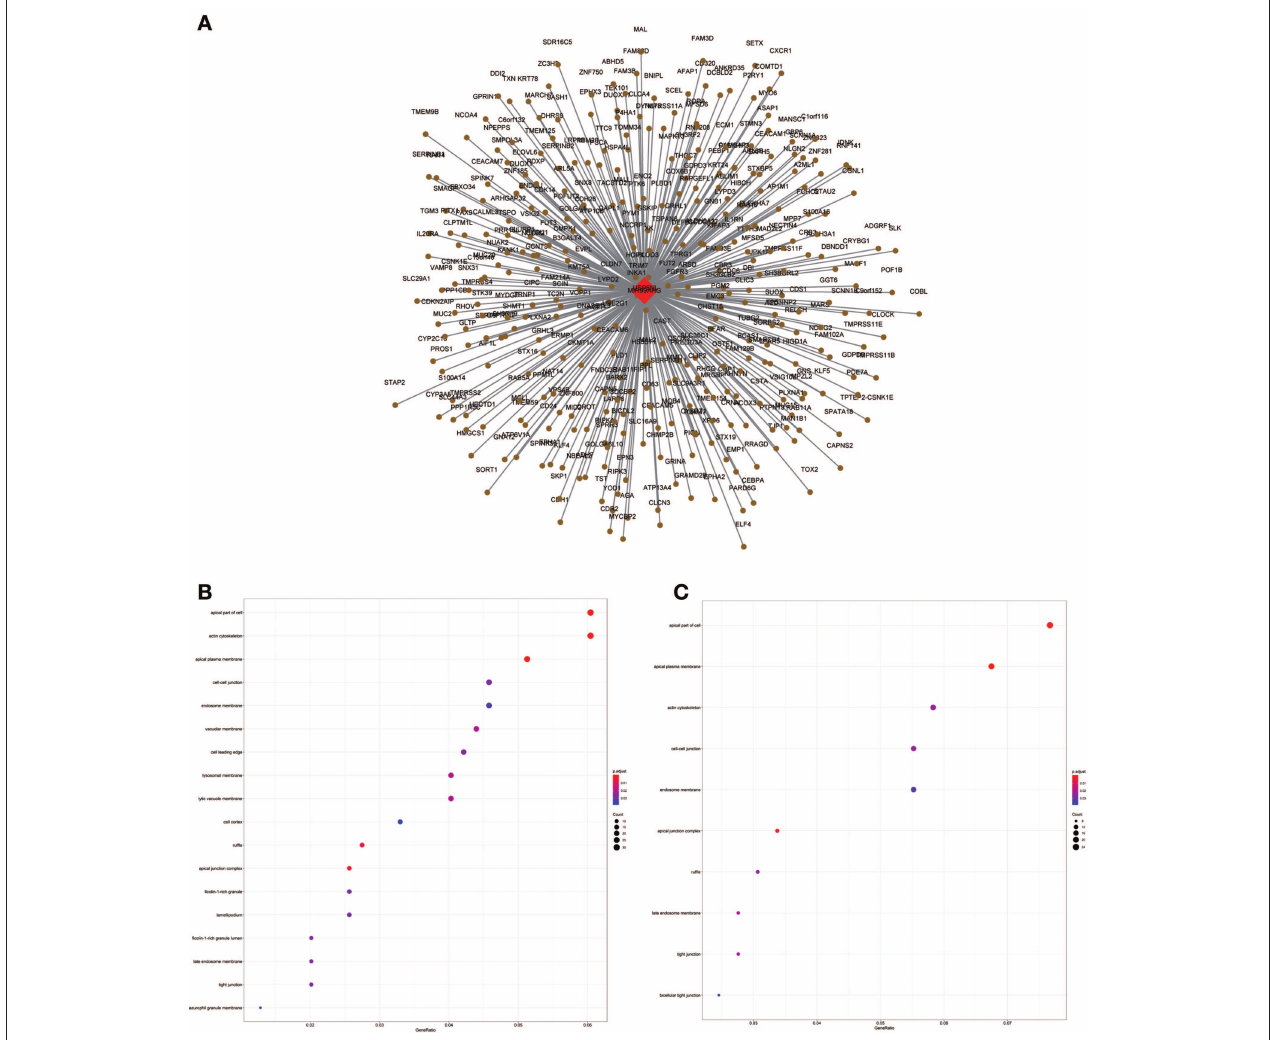
FIGURE 9 | LncRNA-mRNA network in Brown module and functional enrichment. (A) The lncRNA-mRNA network in Brown module, (B) GO-CC enrichment analysis (All genes in Brown module), and (C) GO-CC enrichment analysis (MIR99AHG related genes in Brown module).